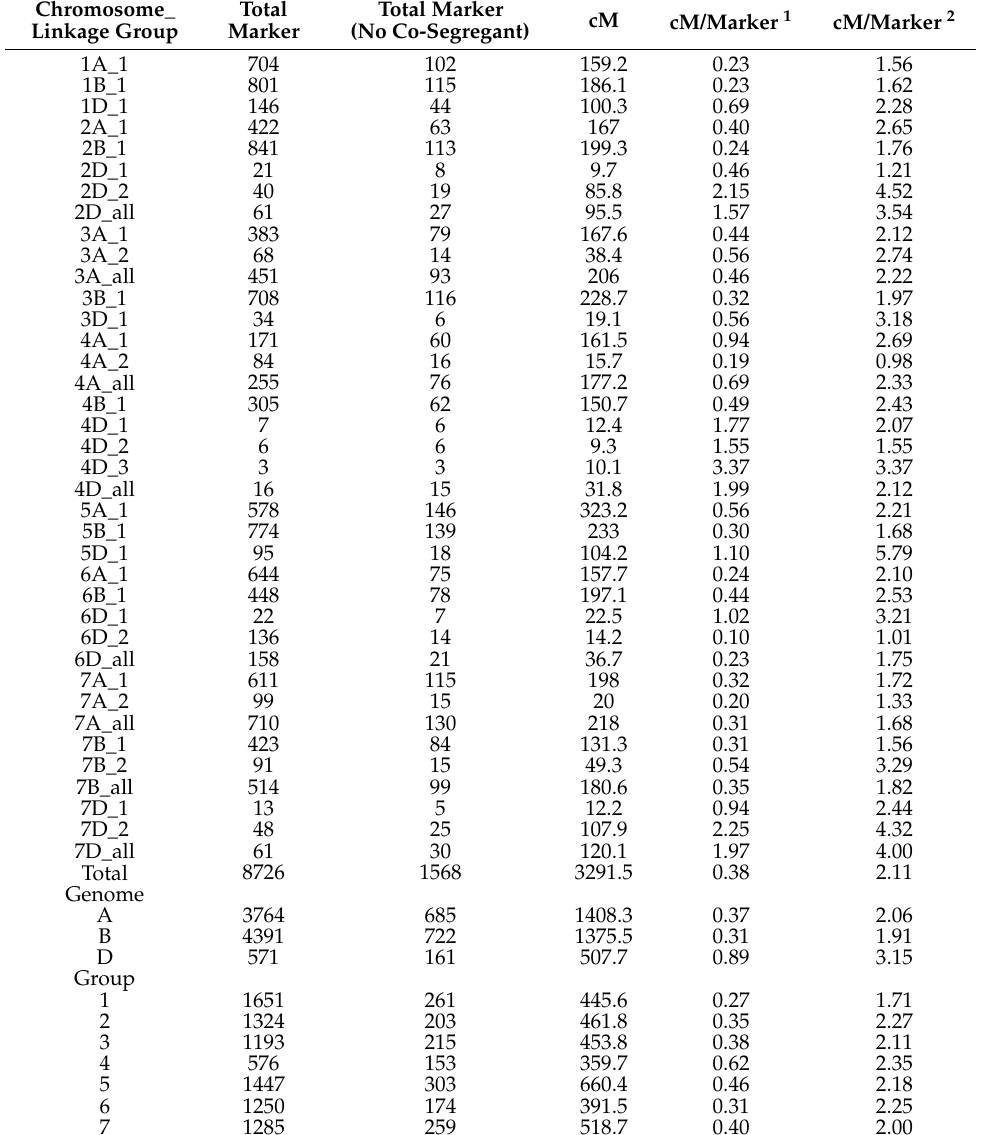
Table 3. Distribution of molecular markers in the chromosomes and homeologous groups of the Victo × Spada bread wheat map. Information on Kosambi centiMorgan (cM) length of the maps across the bread wheat chromosomes, and chromosome-based mean inter-locus separation (cM/marker) is also